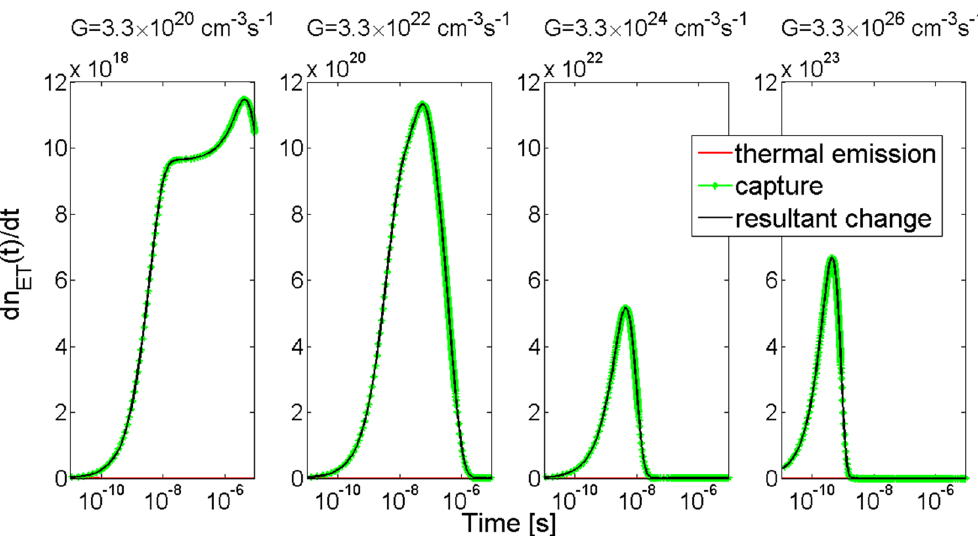
Figure 7. Simulation of rate of change in electron concentration at trap level ET in 4H-SiC material. The green lines show rates of capturing electrons from the conduction band, the red lines show rates of thermal emission of excess electrons from the trap to the conduction band, and the black lines overlaid on the green ones are a resultant rate of change in electron concentration as an effect of simultaneous occurrence of the capturing and thermal emission processes. Parameter G is the generation rate coefficient.